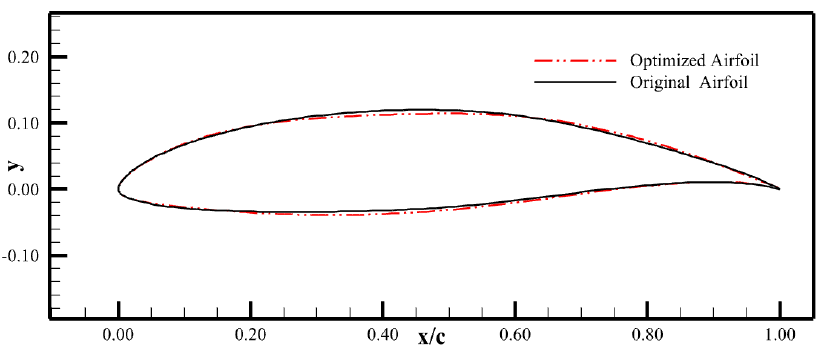
Figure 10. Comparison of shape before and after normal optimization.